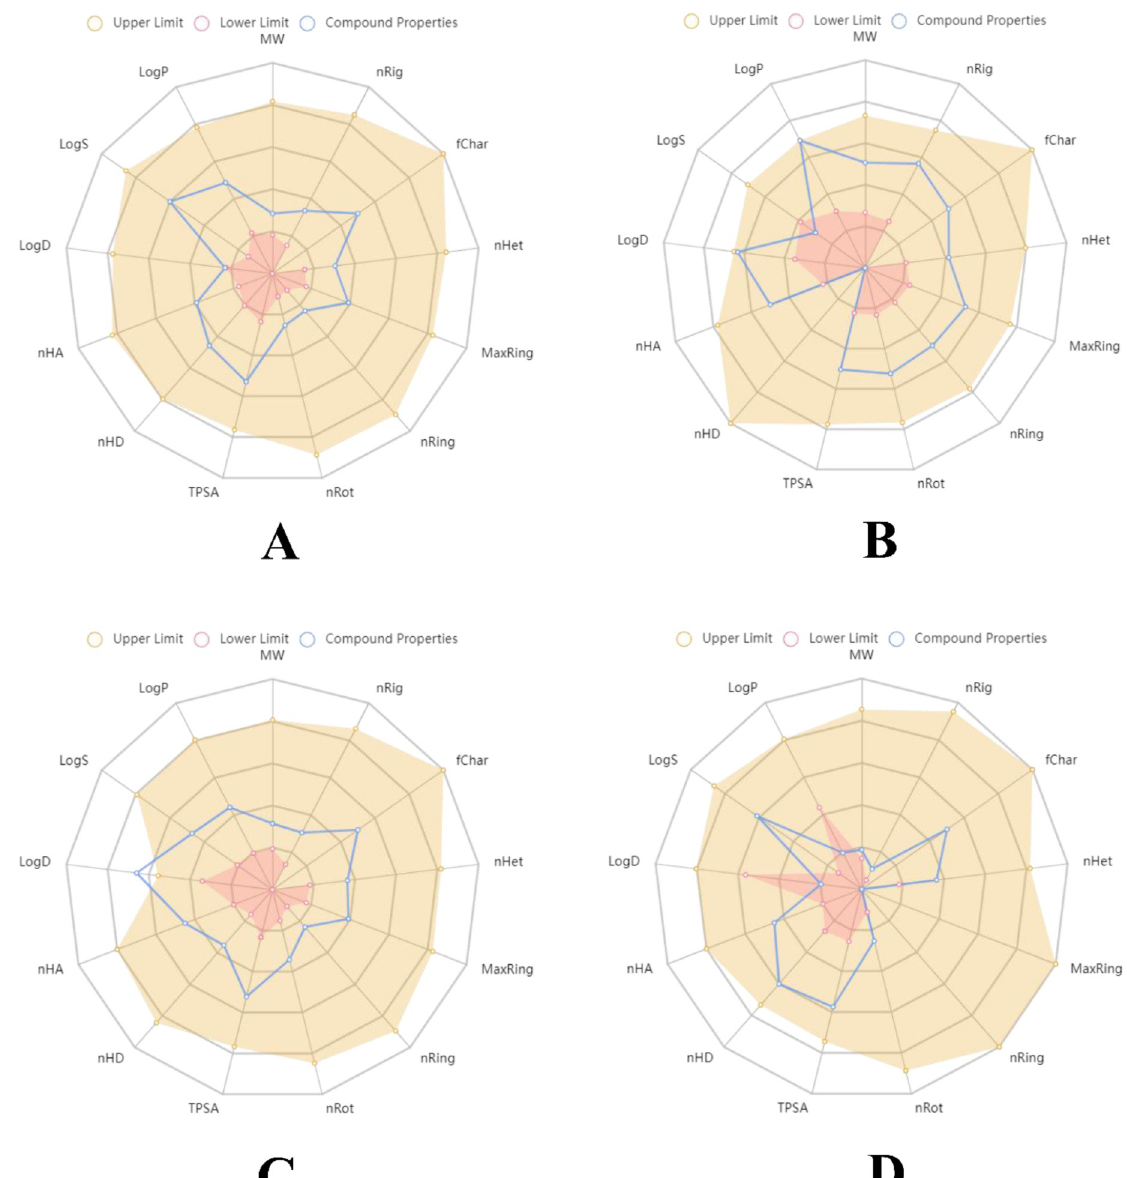
Fig 15. Pharmacokinetic mapping of experimental compounds. A) caffeic acid, B) DBDEA, C) syringic acid, and D) metformin.